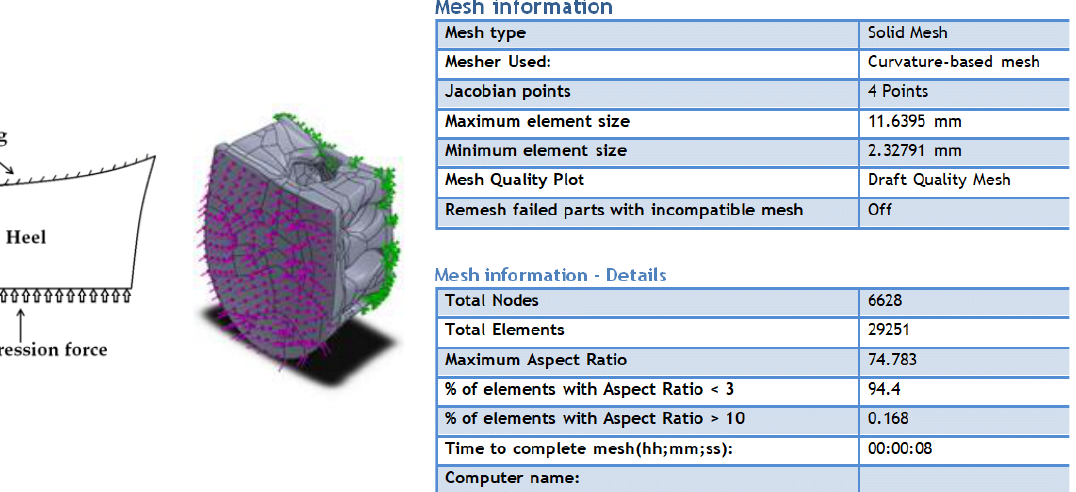
Figure 3. Parameters of the static simulation of designed heels.